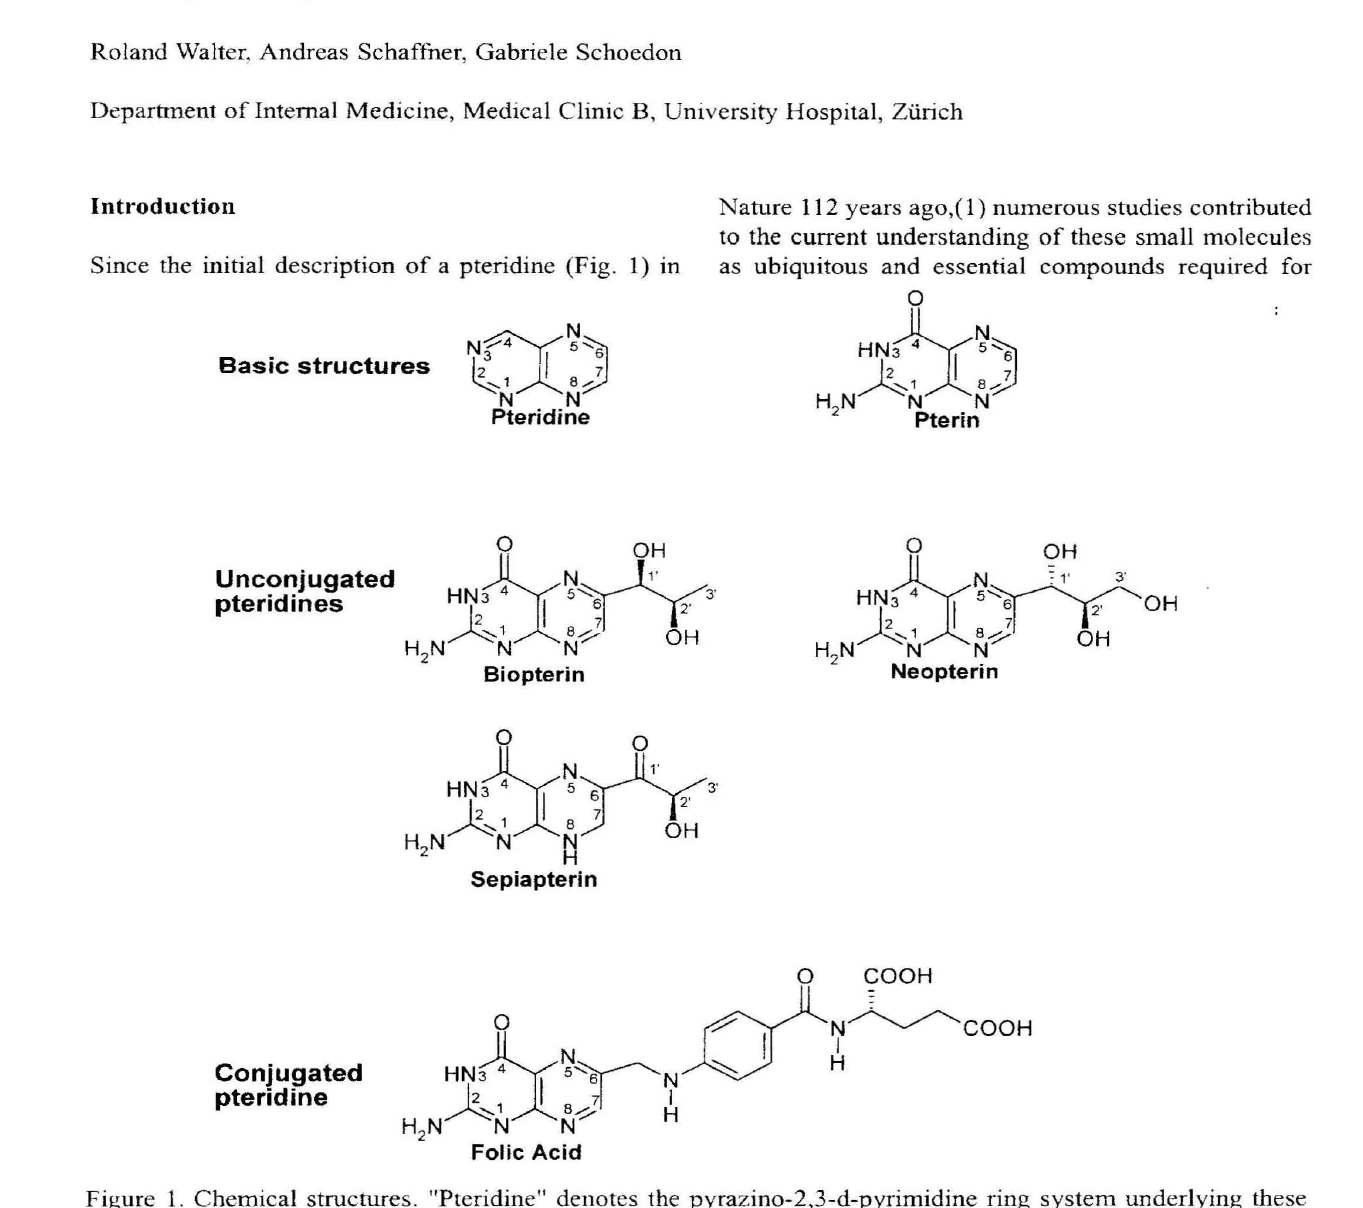
Figure 1. Chemical structures. "Pteridine" denotes the pyrazino-2,3-d-pyrimidine ring system underlying these molecules. The majority of the naturally occurring unconjugated pteridines, e.g. biopterin, neopterin, or sepi apterin, are derivatives of the 2-amino-4-oxo-pteridine, and this bicyclic basic structure has been termed "pterin". Note that sepiapterin is not synthesized in mammals including man. Besides unconjugated pteridines, also con jugated pteridines are widely distributed in nature. Certainly the most important are folates, a g1'OUp of hetero cyclic compounds based on the 4-[(pteridin-6-ylmerhyl lamino ]benzoic acid skeleton conjugated with one or more L-glutamate